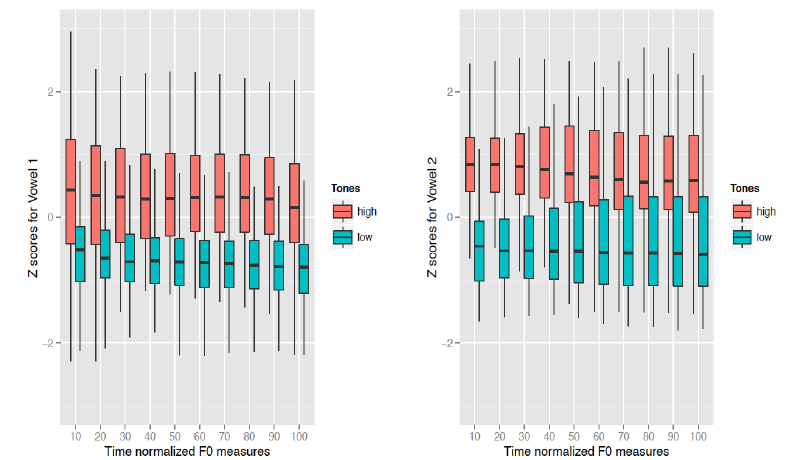
Figure 21: F0 normalized z score distribution in the vowels of the high and low tone